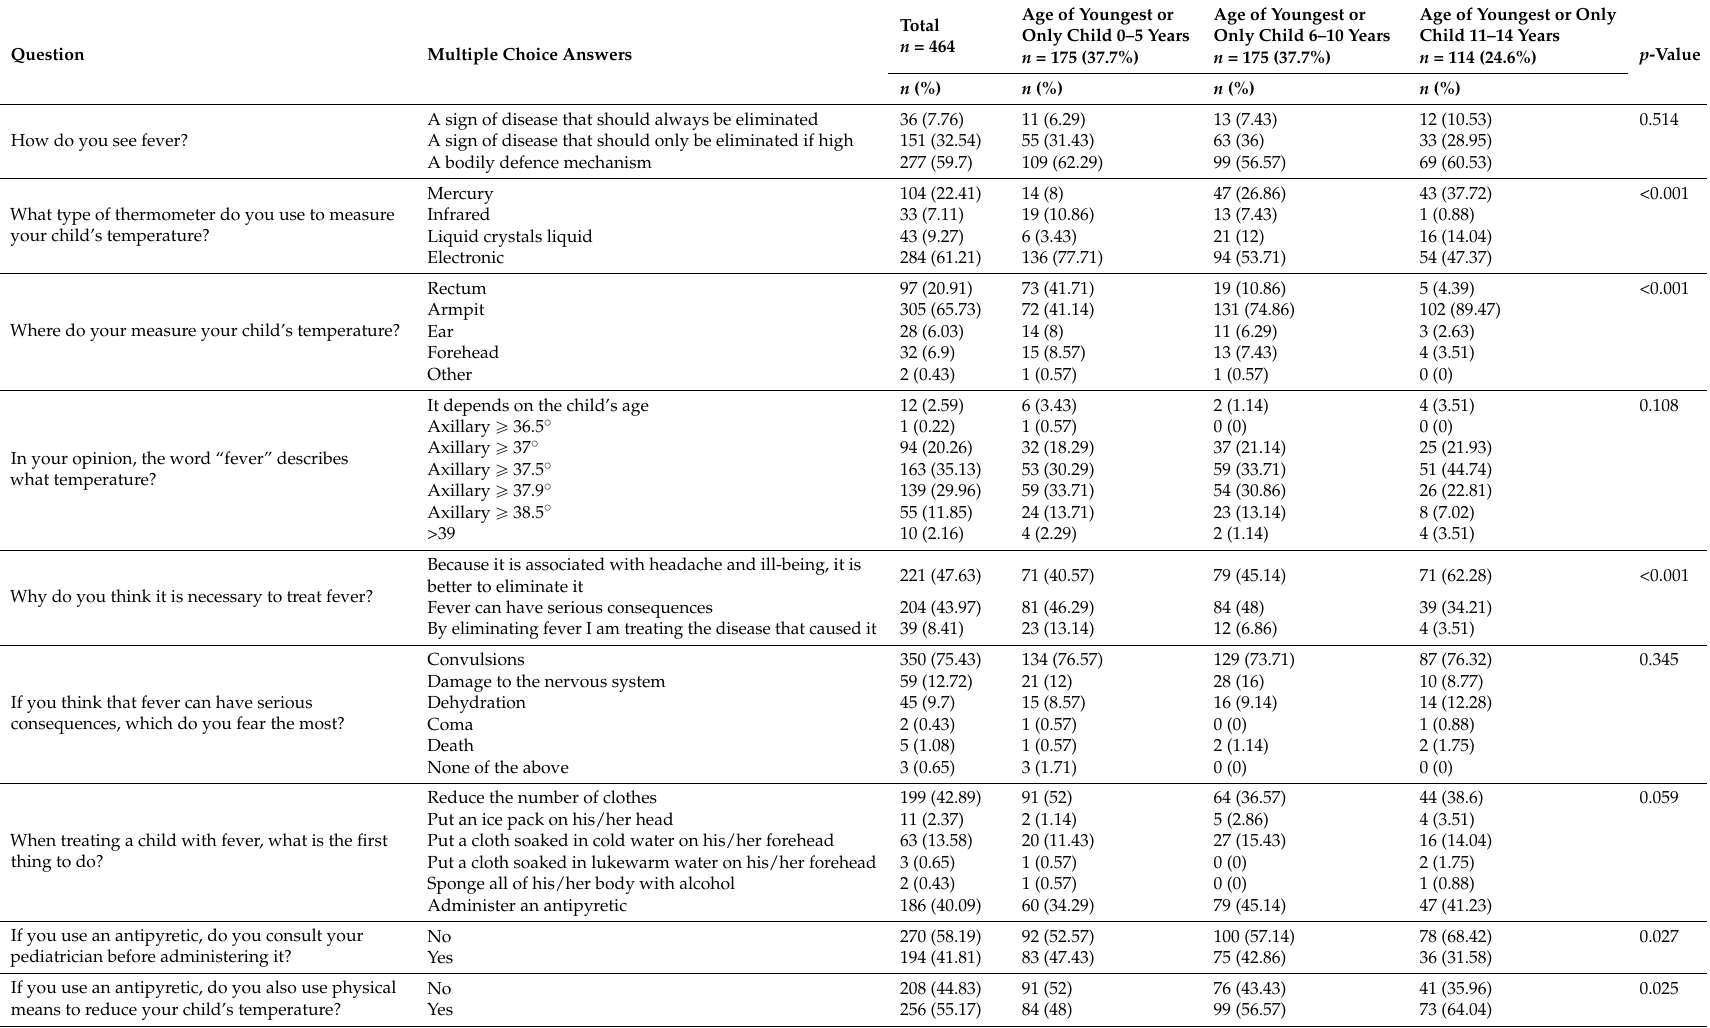
Table 5. Parental management of